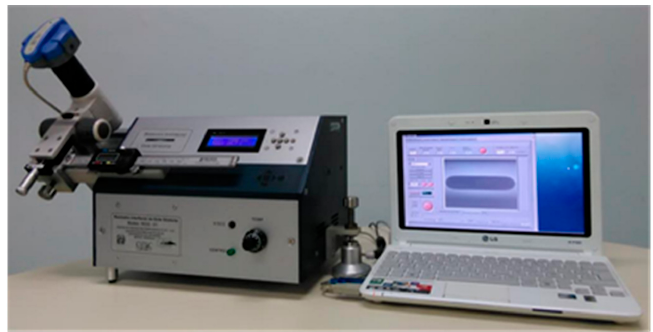
Figure 2. Oscillating spinning drop interfacial rheometer recent version.